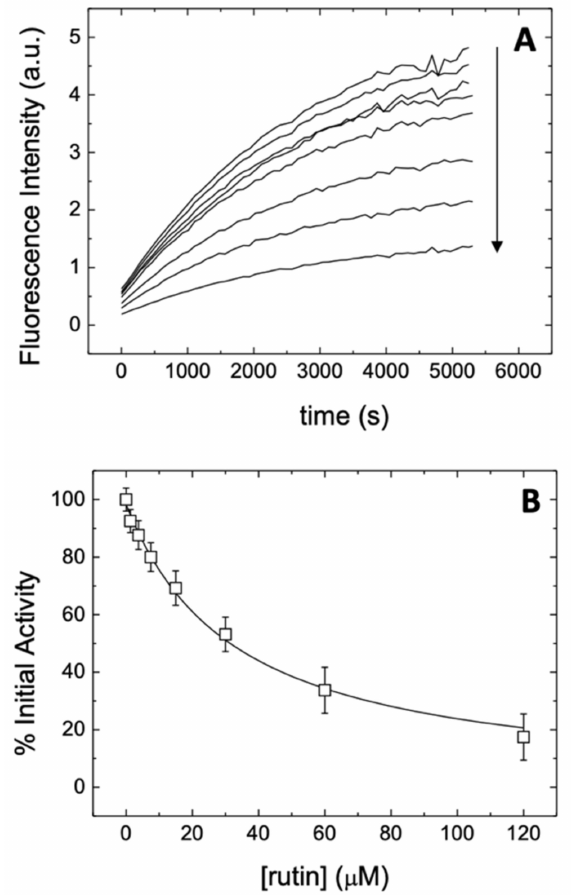
Figure 3. ( A ) Fluorescence emission (in arbitrary units, a.u.) of the substrate as a function of time at varying concentration of rutin. The concentration of the substrate and 3CLpro were fixed at 20 and 2 µ M, respectively, while the concentration of rutin was varied from 0 to 120 µ M following a two-fold serial dilution. The arrow indicates the increase in rutin concentration; ( B ) Experimental inhibition curve for rutin (initial slope as a function of total rutin concentration). Nonlinear least-squares regression data analysis (continuous line) according to Equations (1) and (2) provided an apparent inhibition constant K i app of 31 µ M, and an intrinsic inhibition constant K i of 11 µ